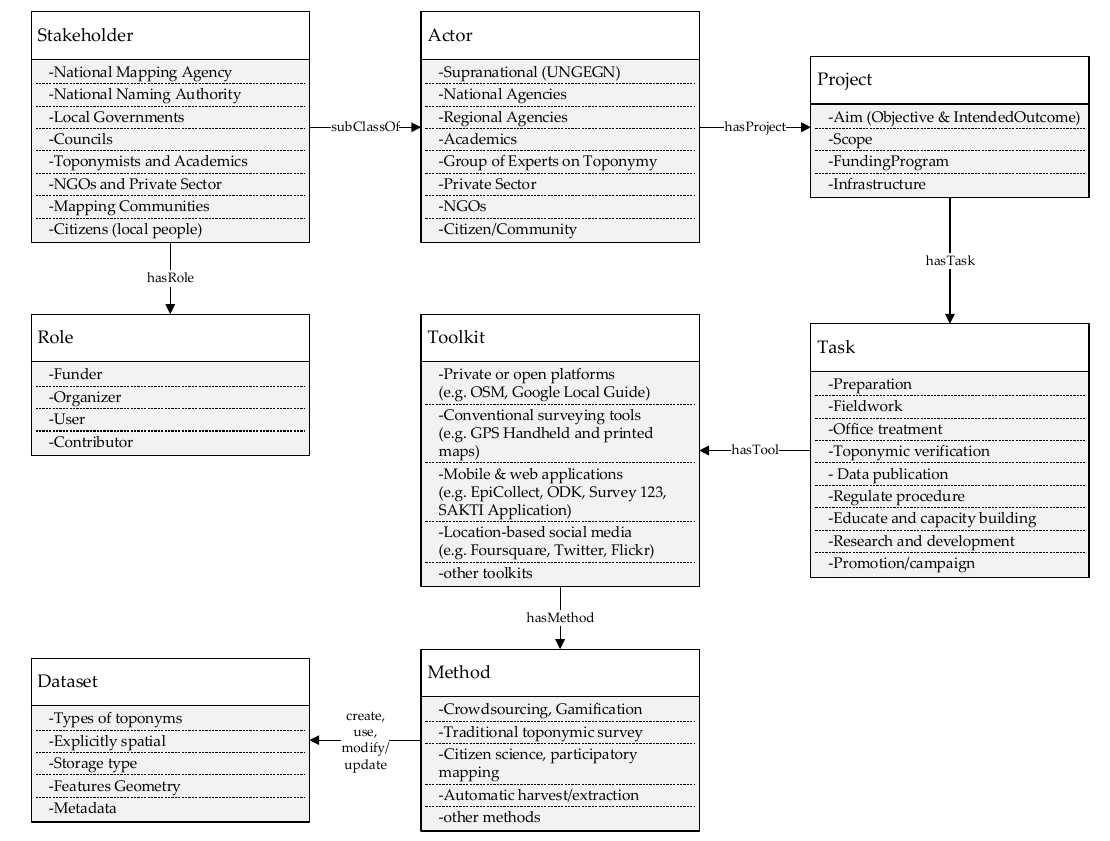
Figure 3. Modified participatory toponym handling (PTH) framework based on stakeholder feedback and citizen science ontology.